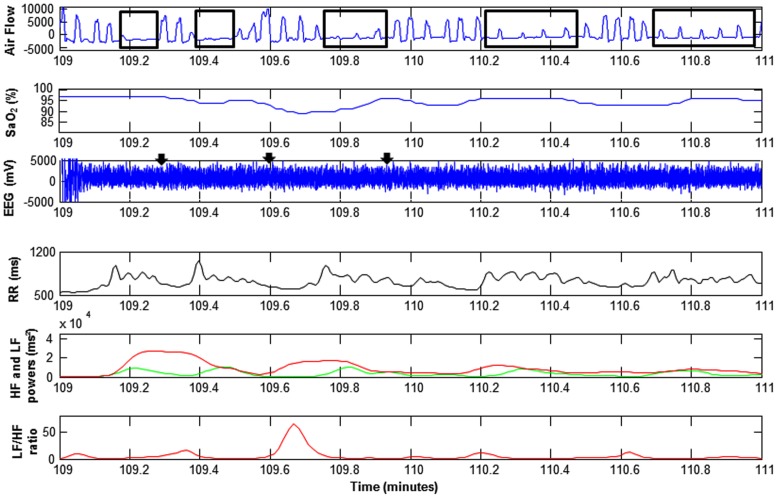
Representative examples of cardiac sympathetic modulation in response to apneas/hypopneas: RR intervals (RR), low (LF: red line) and high frequency (green line: HF) powers and LF/HF ratio (red line).Obstructive hypopnea and apnea were observable on air flow (black rectangles), with oxygen desaturations (SaO2≥3%), and sometimes with cortical arousals. Cortical arousals were represented by black arrows, were detected on 3 electroencephalographic leads F3-F4; C3-C4; O1-O2 defined as bursts of wakefulness-related cortical activity lasting more than 3 s scored by expert in sleep studies based on 30-s epochs, but only C3-C4 lead was represented.